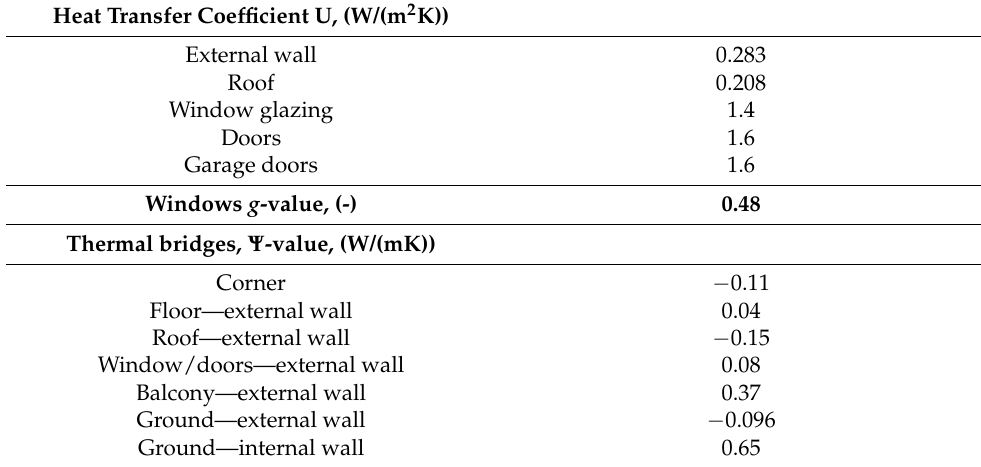
Table 2. Thermal parameters.